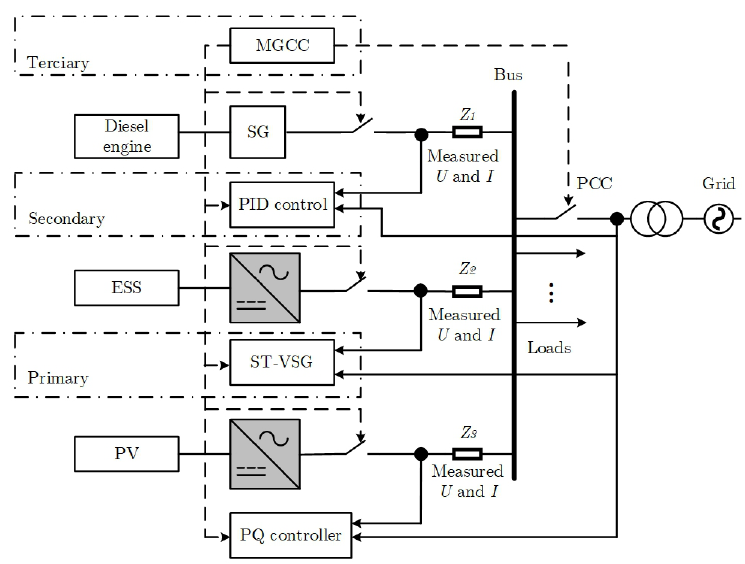
Figure 4. Hierarchical scheme for control of Photovoltaic (PV)-battery-diesel microgrids (MGs)